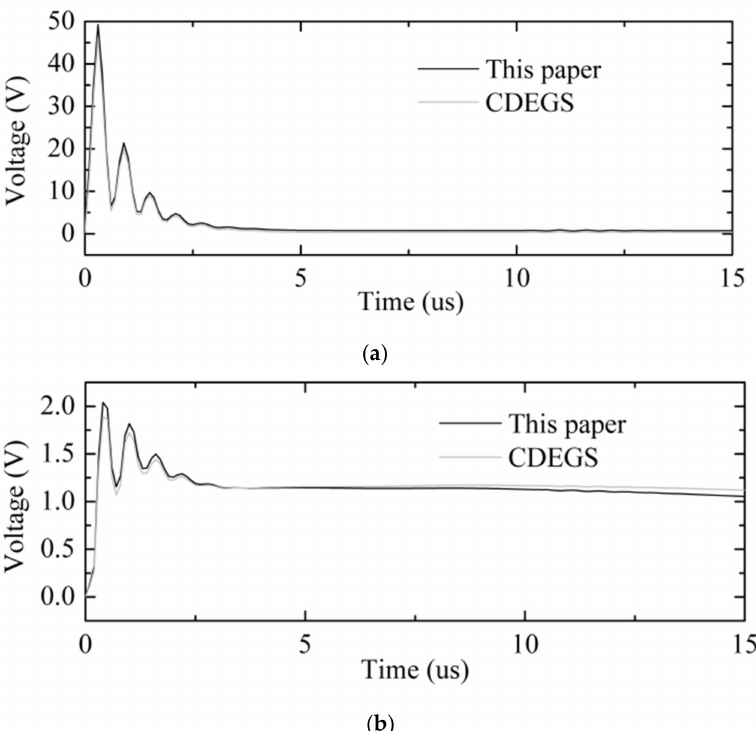
Figure 6. Comparison of the Potential distributions with different numerical methods. ( a ) Potential on the top of the tower, ( b ) Potential at one foot of the